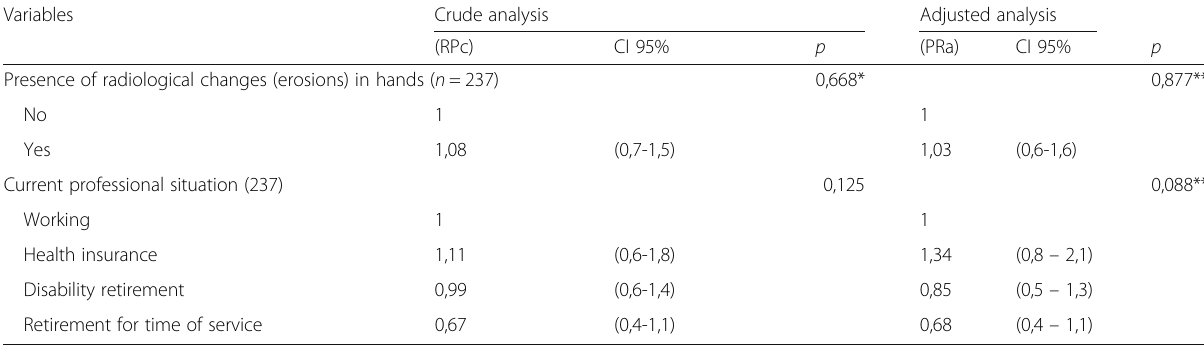
Table 3 Crude and adjusted regression analysis of diagnostic time up to 12 months and independent variables in patients with rheumatoid arthritis in Blumenau, Santa Catarina, Brazil, 2014